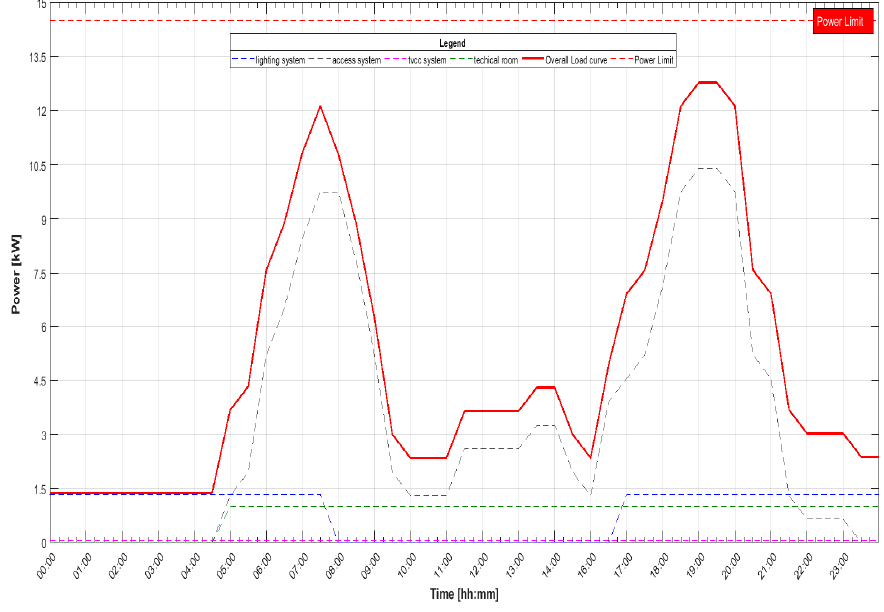
Figure 9. Overall load curve of the car park.